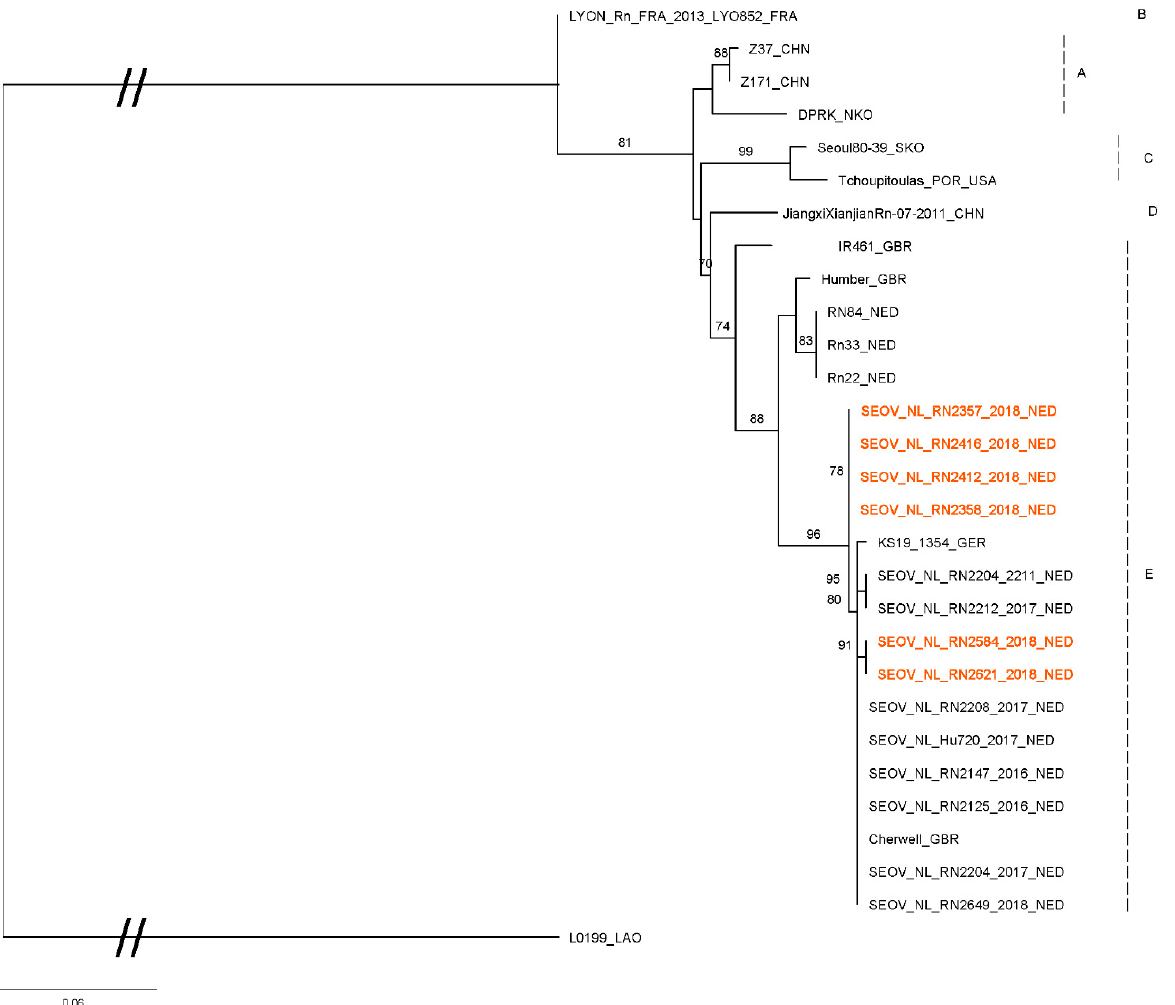
Figure 3. Maximum likelihood phylogenetic tree for SEOV partial L segment (333nt) sequences, 2008 Rattus tanezumi SEOV (L0199) from Laos (HQ992814) was used as an outgroup. Sequences from this study are shown in red (Genbank accession numbers MT993925-993630). The quality of one of the sequences from the rattery rats was too low to include in this comparison. Numbers along branches are bootstrap values, only bootstrap support of >70% are shown. Scale bar indicates nucleotide substitutions per site. Letters behind branches refer to groups of SEOV sequences as described by Kim et al. [23]. At the end of the strain names the country of origin is given: BEL, Belgium; CHN, China; FRA, France; GBR, Great Britain; GER, Germany; LAO, Laos; NED, the Netherlands; NKO, North Korea; SKO, South Korea; and USA, United States.